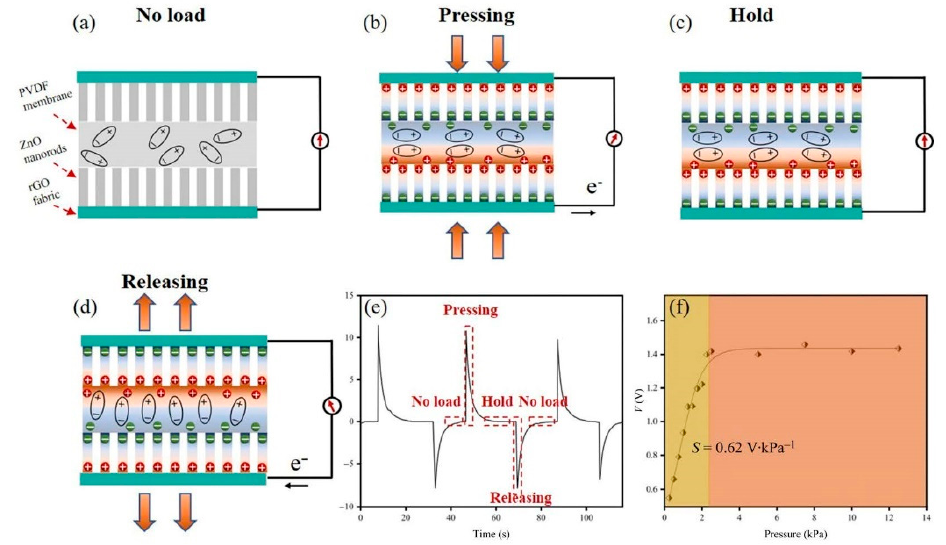
Figure 2. Illustration of a piezoelectric pressure sensor at different load states ( a – d ) and output voltage response for each state ( e ) and under varied pressure ( f ). Reprinted with permission from Springer Nature [50]. Copyright 2021 Springer Nature.